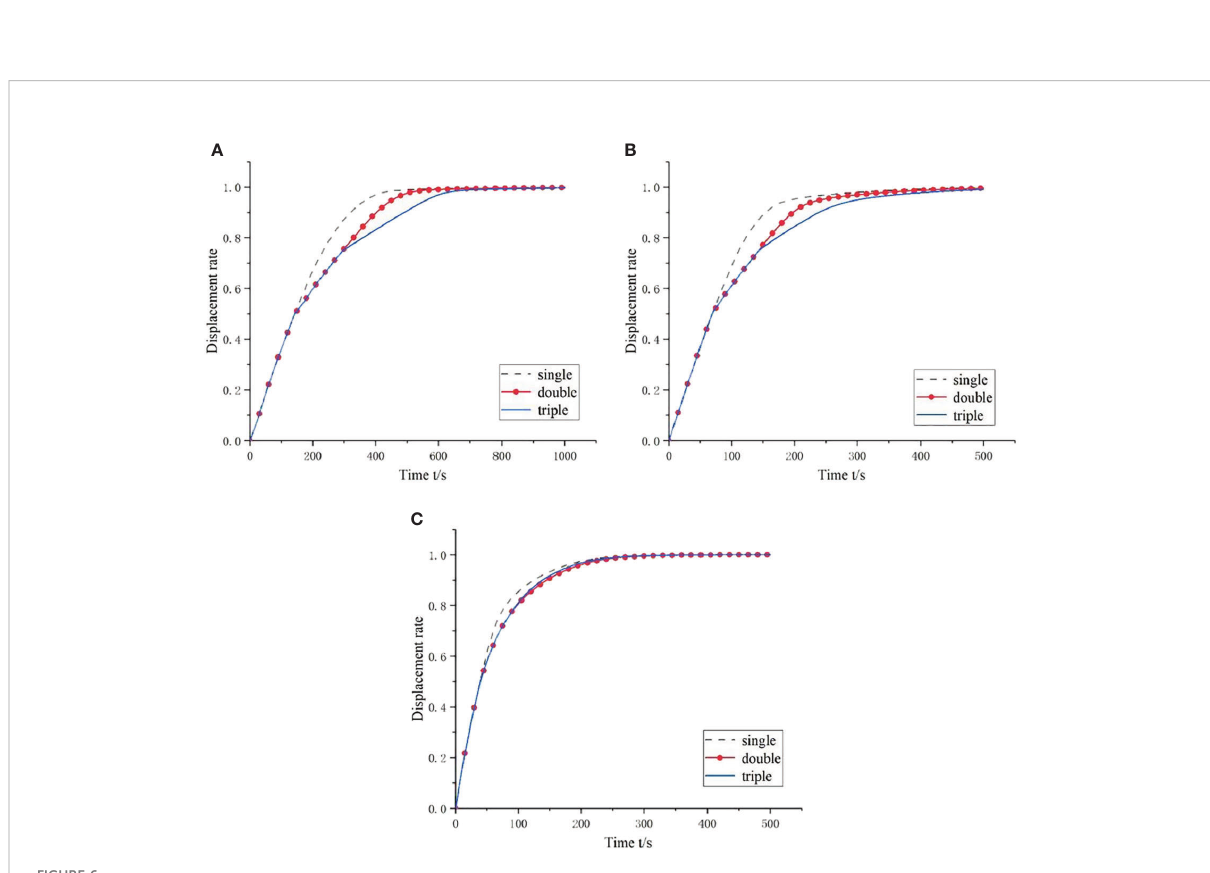
FIGURE 6 The diagram of the indirect displacement process, (A) 0.044m/s, (B) 0.1m/s, (C) 0.2m/s.